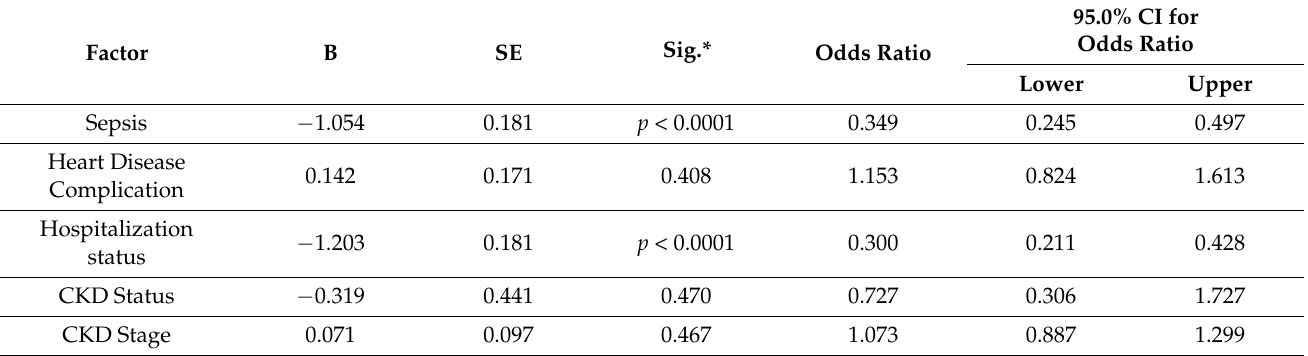
Table 5. Contributing factors to the mortality rate in hospitalized patients with COVID-19.